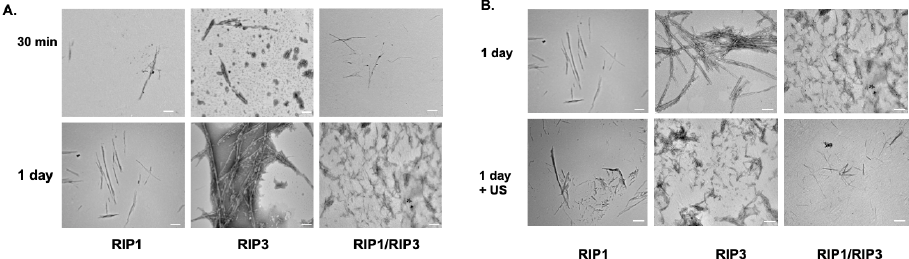
Figure 4. ( A ) Transmission electron microscopy (TEM) images of 12 amino acid RHIM fragments RIP1, RIP3, and RIP1/RIP3 aggregation kinetics. The images reveal significant aggregation after 1 day compared to 30 min. Scale bar 100 nm. ( B ) Ultrasound (US) mediated mechanosensitive effects of aggregates assessed with TEM. The images reveal the aggregates mechano sensitivity to ultrasound 2.2 W/cm 2 , 5 min. Scale bar 100 nm.